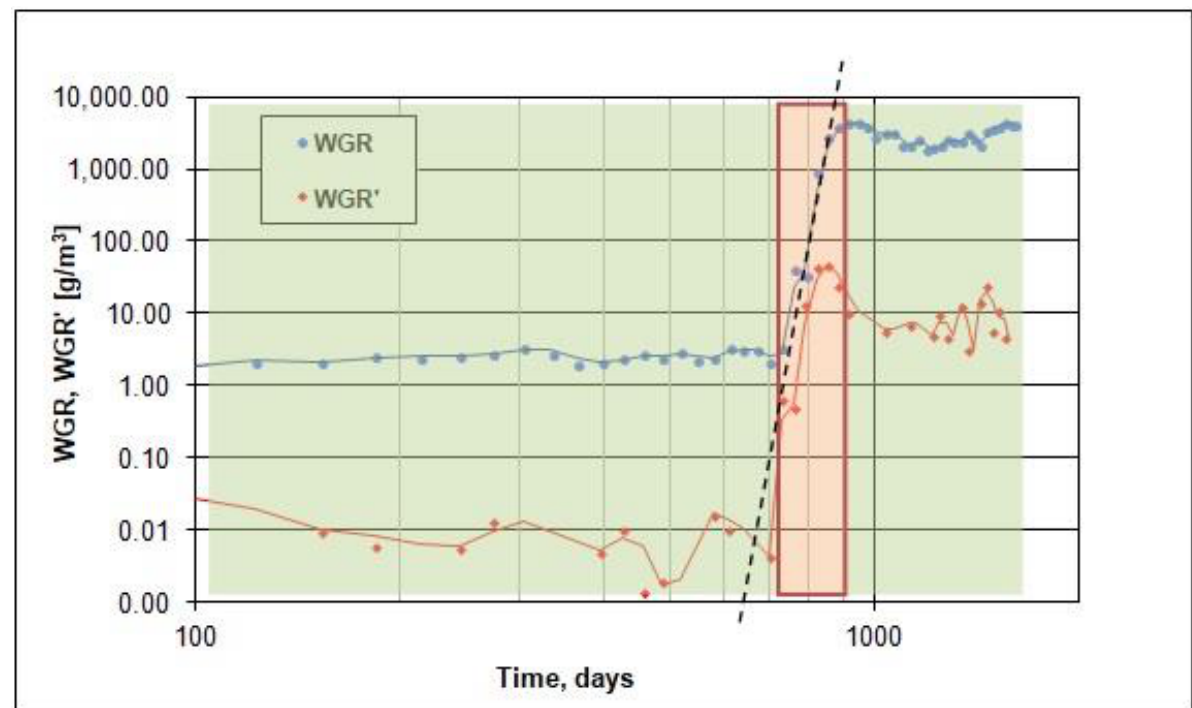
Figure 2. The diagnostic window technique for the assessment of the water breakthrough mechanism to the well .